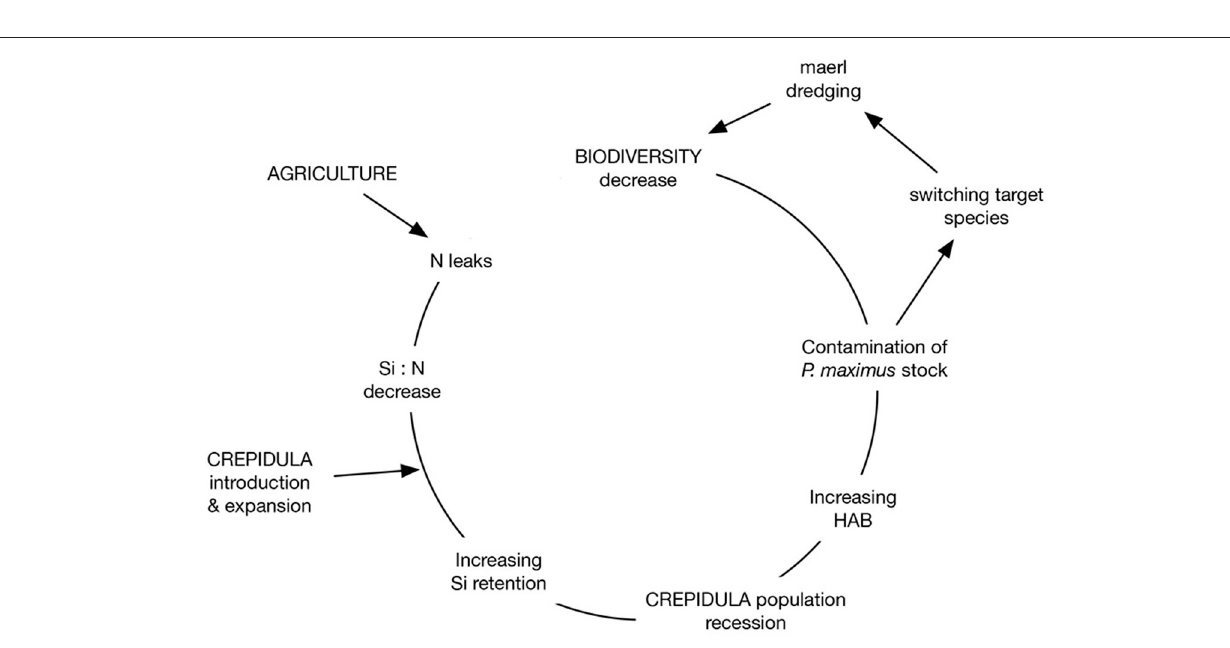
FIGURE 4 | Schematic description of a cascade of events over the last 50 years in the Bay of Brest, from changes in agricultural practices after world war II to present-day threats on biodiversity, including interactions between changing nutrient ratios and the proliferation of Crepidula fornicata (see text) and their impacts on the Great Scallop